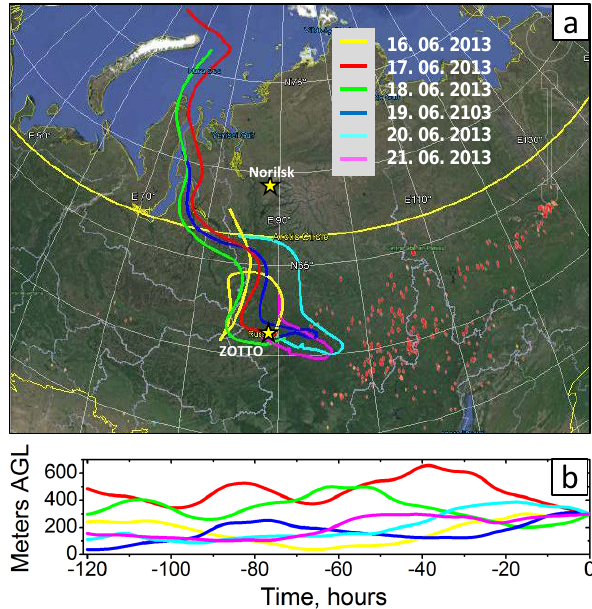
Figure 1. (a) 120h HYSPLIT air-mass backward trajectories during the sampling period at ZOTTO at 300m from 16 to 21 June 2013 and (b) their height above ground level (a.g.l.). Red dots indicate the fire locations within the sampling